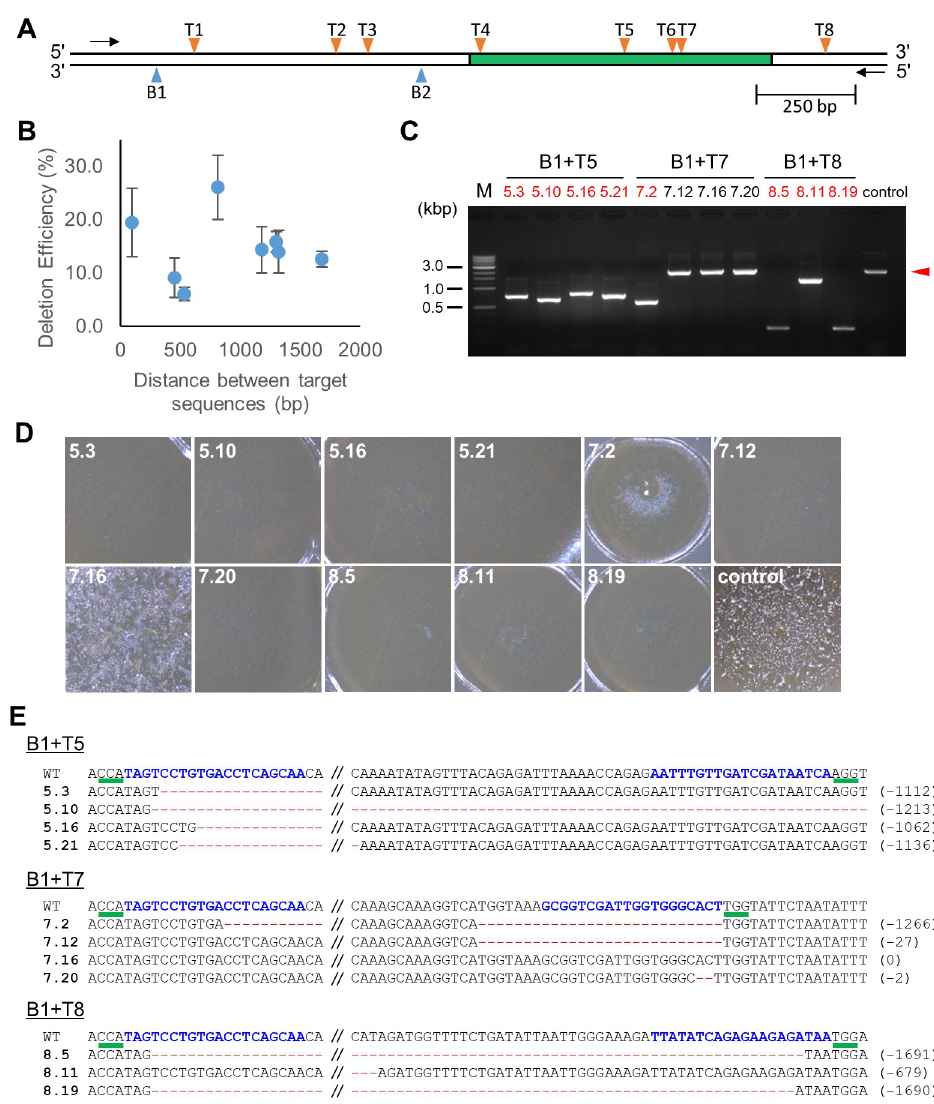
Fig 2. Long genomic deletions generated via use of paired Cas9 nickases. (A) Target sites in the pkaC gene locus. The position of each target site is indicated by an arrowhead. The arrows indicate the locations of the PCR primers used to detect the deletions. The box in green represents the protein kinase domain predicted by UniProt. (B) Analysis of the deletion efficiencies of paired Cas9 nickases. A total of 22 independent clones were isolated from individual transformations and scored for the presence of deletions via PCR. The error bars show the standard error of the mean based on three independent transformations. (C) Representative genomic deletions detected by PCR. The arrowhead indicates product size found in the control (the AX2 genome). Clone numbers are shown in red and black, and indicate obvious and unapparent deletions, respectively. (D) Aggregation phenotypes of the mutants. (E) Representative DNA sequences of the target region. The PAM sequences are shown by green underscores. The sgRNA-matching sequences are shown in blue. The mutated nucleotides are in red, and the numbers in parentheses indicate the number of deleted